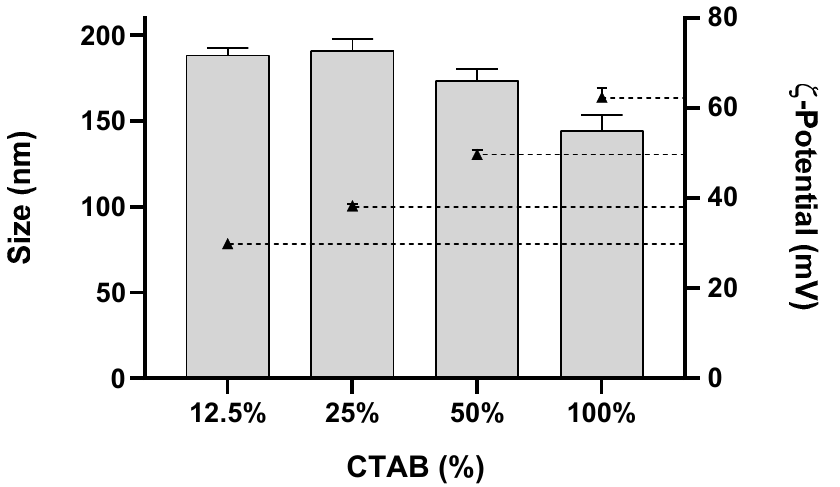
Figure 1. Effect of CTAB/Tween ® 60 ratios on NLC size and ζ -potential. Size was determined using dynamic light scattering (DLS) and ζ -potential using electrophoretic light scattering (ELS). Data are expressed as means ± standard deviation. Bars represent NLC size (average diameter), and triangles with dotted lines represent ζ -potential values: 30 ± 0.3, 38 ± 0.4, 50 ± 0.9 and 62 ± 2 mV. NLC composed of 100% CTAB had a mean size of 148 ± 7 nm and a surface charge of +62 ± 2 mV (Figure 1). Reducing the CTAB percentage (increasing Tween ® 60), increased NLC size (from 148 ± 7 to 188 ± 4 nm), while the surface charge diminished (from +62 ± 2 to +30 ± 0.3 mV). NLC with 12.5% CTAB (NLC CTAB) were selected for further assays |30|mV) to the blank